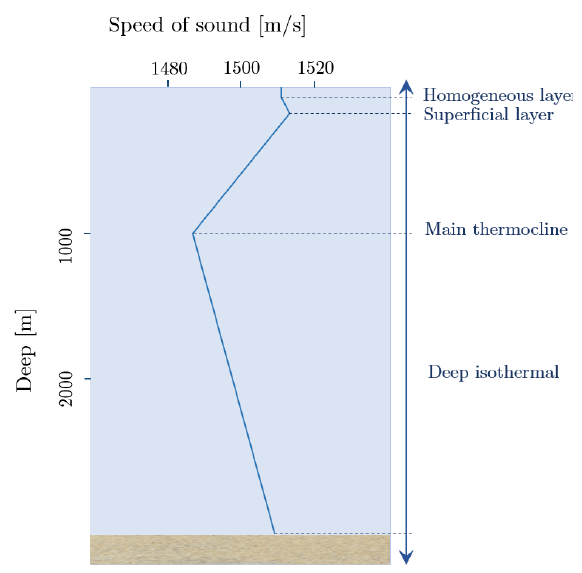
Figure 9. Typical profile of the speed of sound in sea water. Up to 300 m there is the surface layer, from 30 m and up to 1000 m the thermocline layer is included and from 1000 m the isothermal layer. Results of the Propagation Comparison between a Conventional and Parametric